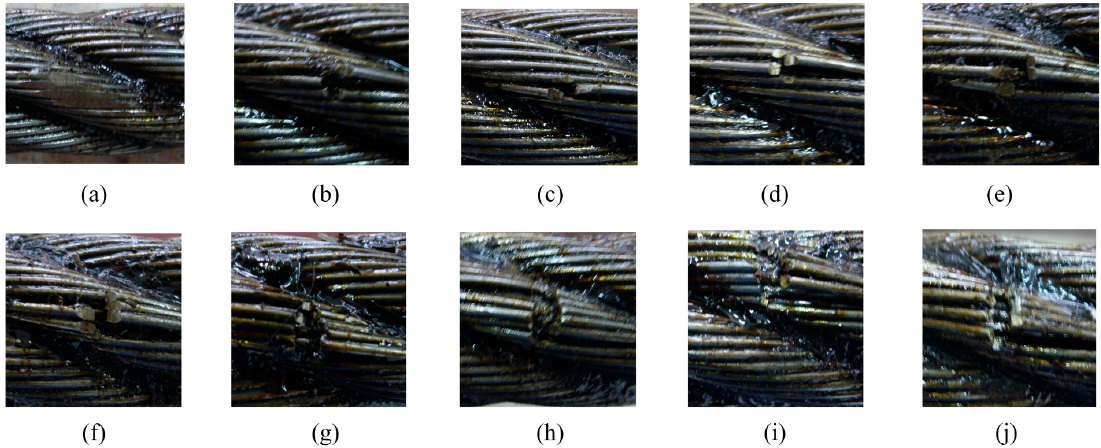
Figure 5. Manufacturing standard small gap defects: ( a ) worn wire at 1.1 m; ( b ) two wires broken at 1.22 m; ( c ) one wire broken at 1.46 m; ( d ) one wire broken at 1.67 m; ( e ) two wires broken at 2.02 m; ( f ) three wires broken at 2.52 m; ( g ) five wires broken at 3.04 m; ( h ) five wires broken 3.54 m; ( i ) seven wires broken at 3.97 m; ( j ) four wires broken at 4.31.